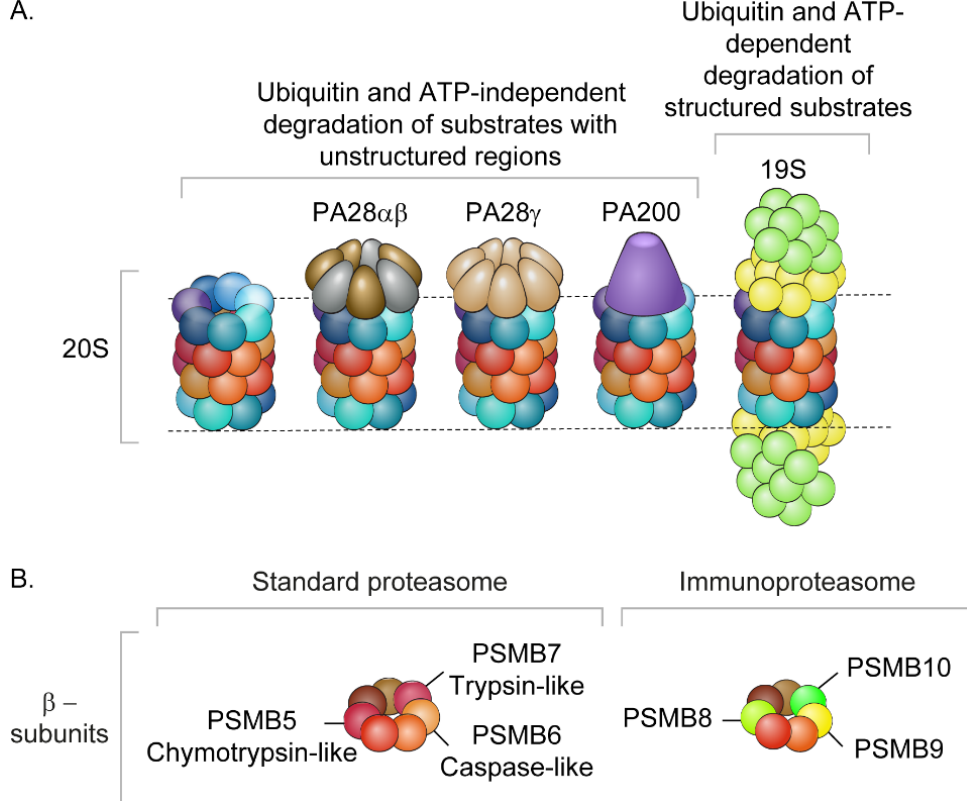
Figure 1. Two alternative proteasomal degradation mechanisms, which are not mutually exclusive, exist in cells. The first is ubiquitin- and ATP-independent, while the second is dependent of both. ( A ). Ubiquitin- and ATP-independent degradation can be undertaken by the free 20S proteasome complex. This complex is composed of 28 subunits arranged in a cylindrical structure comprising four heptameric rings: two outer α -subunit rings (PSMA1–PSMA7, colored in cool colors) that embrace two central β -subunit rings (PSMB1–PSMB7, colored in warm colors). Alternatively, the 20S complex can be capped at one or both ends by the proteasome activators; PA28 α / β , PA28 γ , and PA200. PA28 α / β (gold and silver) and PA28 γ (beige) form hetero-and homo-heptameric rings, respectively, while PA200 (colored in purple) is a monomeric protein. On the other hand, ubiquitin and ATP- dependent degradation is performed by the 26S and 30S proteasomes that are formed by binding of one or two 19S regulatory complexes to the 20S proteasome, respectively. Two substructures form the 19S regulatory particle: the lid (colored in green) and the base (yellow). Hybrid proteasomes can also be generated when the 20S proteasome is capped with two different activators, mainly the 19S particle, and either PA28 α / β and or PA28 γ . ( B ). Three of the 20S proteasome β -subunits, PSMB5, PSMB6 and PSMB7, are catalytically active. The immuno-proteasome contains three alternative catalytic subunits: PSMB8, PSMB9 and